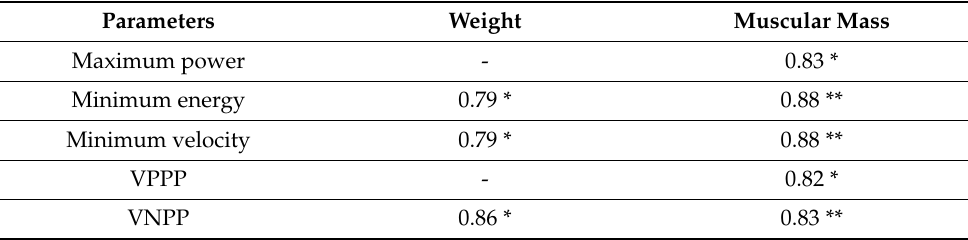
Table 3. Correlations between centre of mass (COM) kinematic parameters and anthropometric ones.